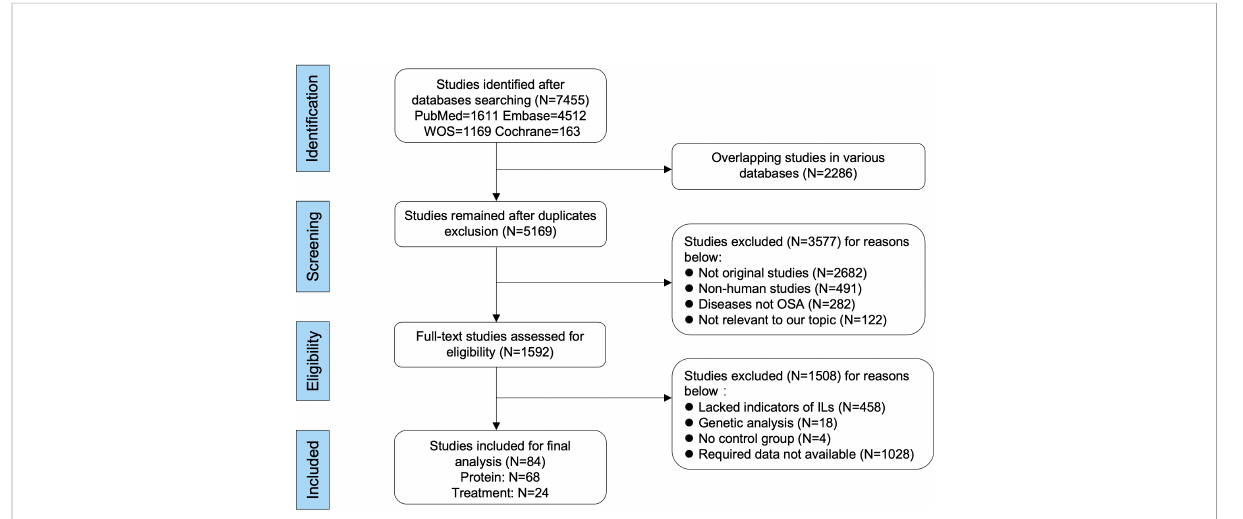
FIGURE 1 Flow diagram of literature selecting based on the inclusive and exclusive criteria. Among the included 84 publications, 68 studies were used for comparing the differences of interleukin levels between OSA and healthy control, and 24 studies were used for analyzing the changed levels of interleukins in patients with OSA responding to treatments. The format and unit of measurements were mean ± standard deviation and picograms per milliliter,